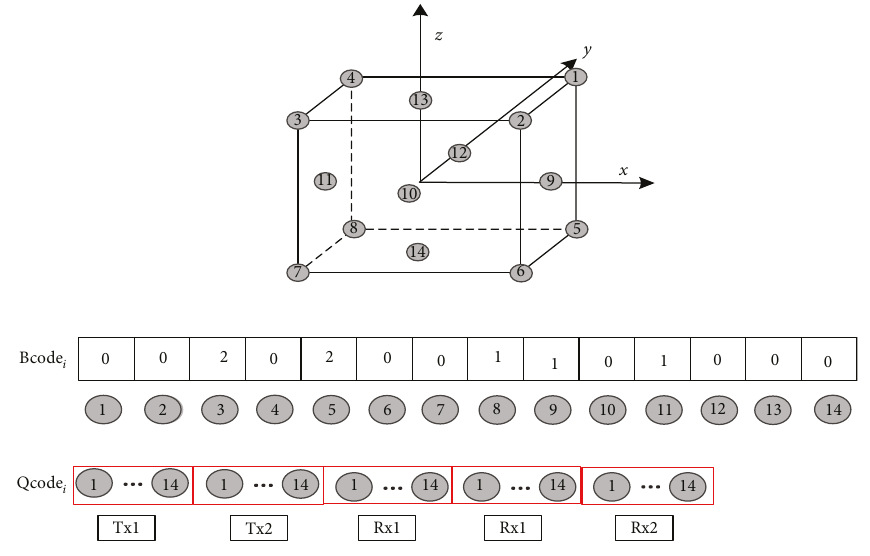
Figure 3: Encoded method of